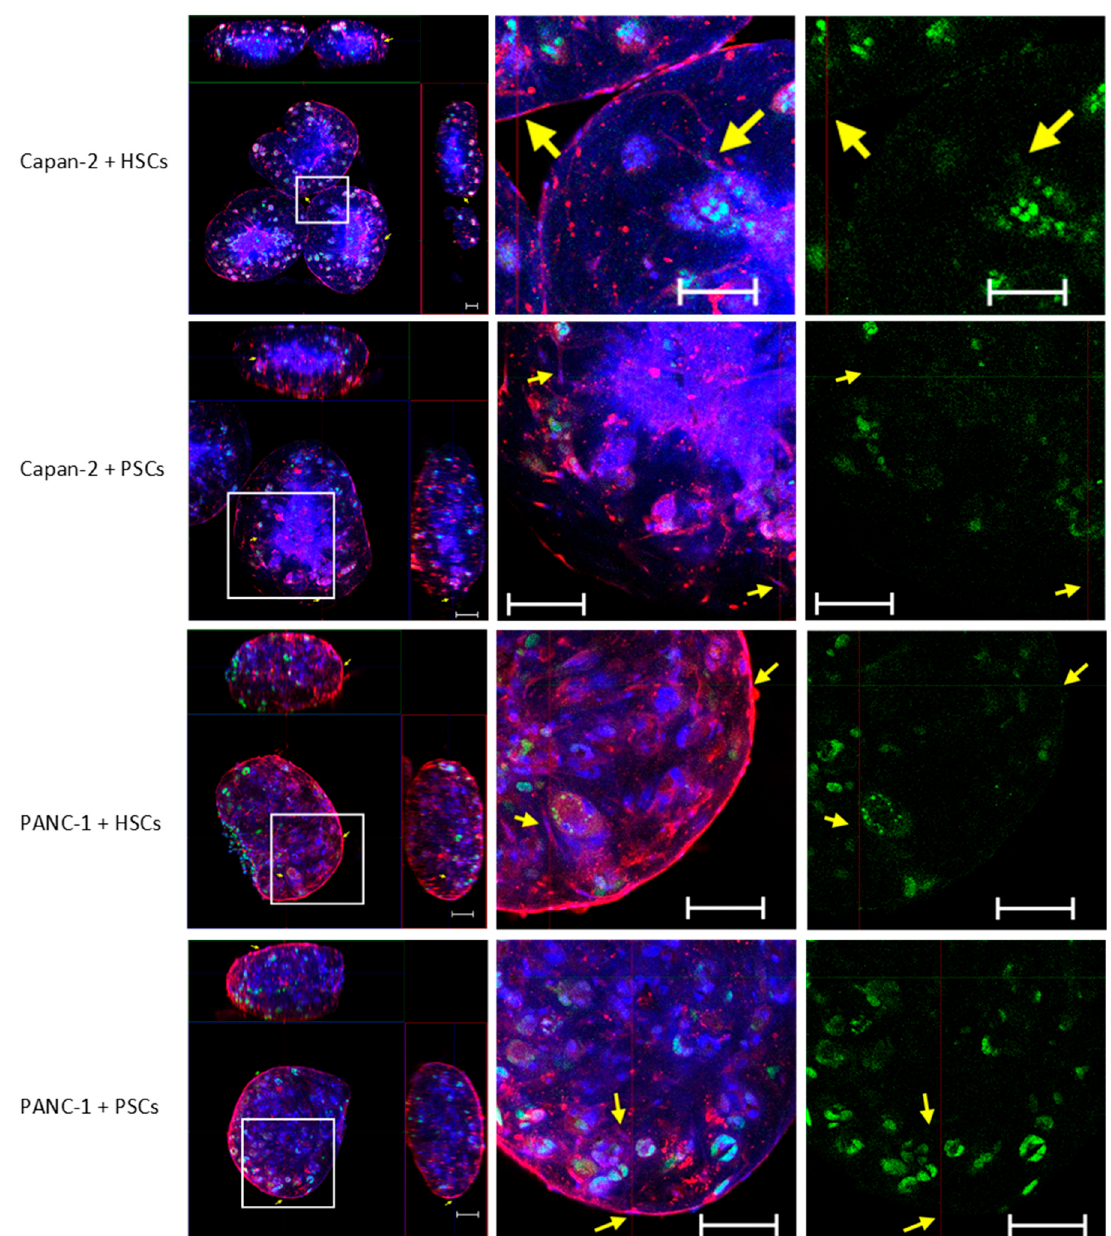
Figure 2. Distribution of the stellate and cancer cells in 3D spheroids using confocal laser scanning microscopy. At day 4 of culture, spheroids formed from 500 cancer cells (PANC-1 or Capan-2) and 1000 hepatic stellate cells (HSCs) or pancreatic stellate cells (PSCs) in 50 µL of 0.1 mg/mL human type I collagen were fixed and stained for α -SMA (red) and p53 (green), with DAPI (blue) being used to demonstrate the nuclei. Yellow arrows indicate stellate cells. Images are representative from at least three independent experiments with at least three spheroids in each experiment. Scale bar: 100 µm.